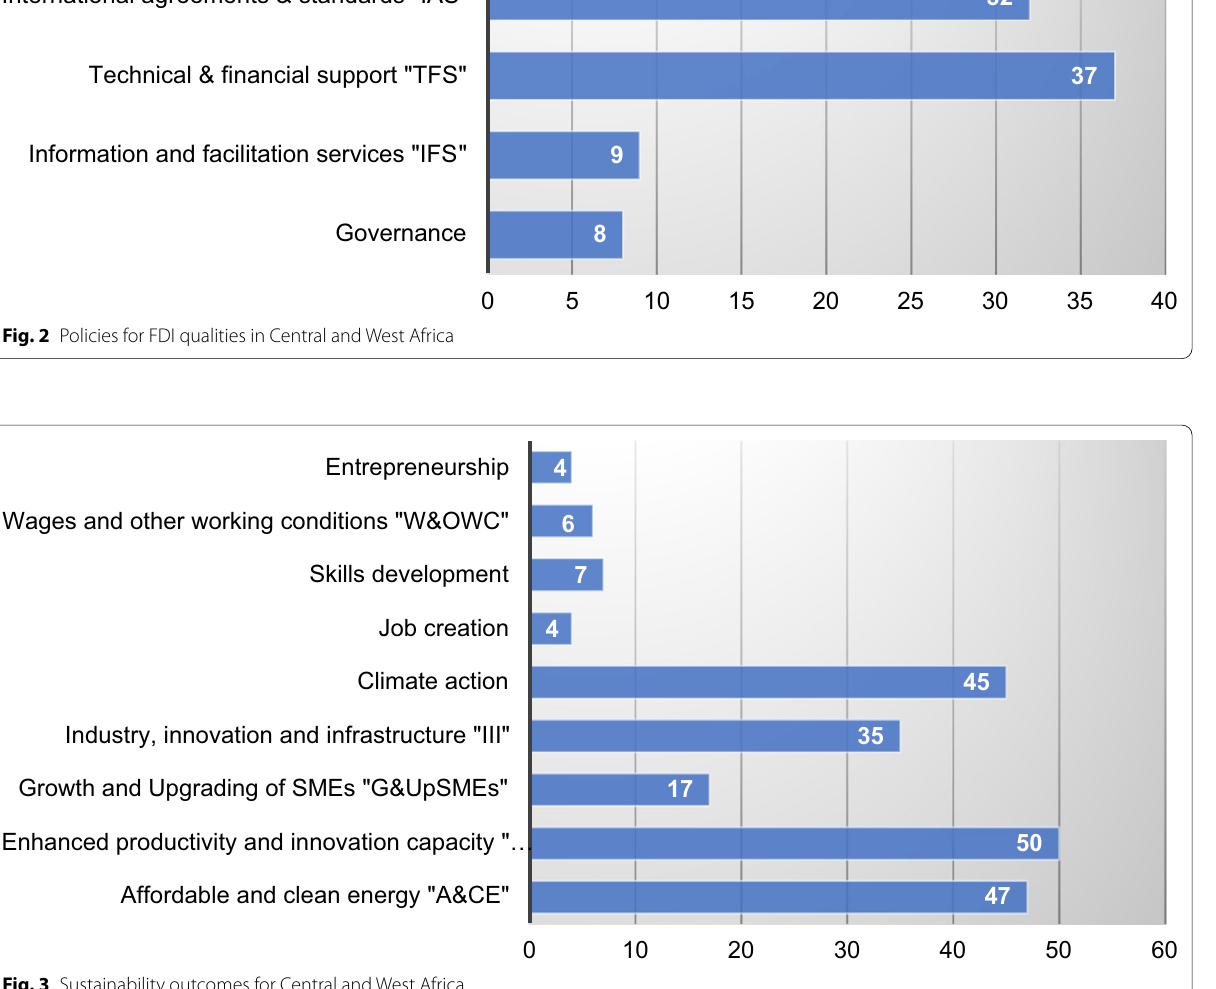
Fig. 3 Sustainability outcomes for Central and West